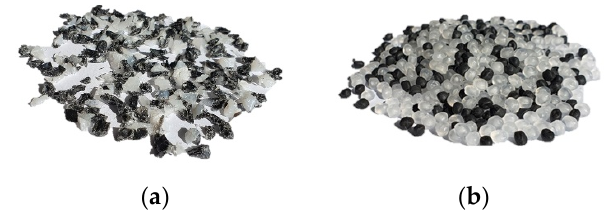
Figure 1. ( a ) Regrind material; ( b ) virgin material granules. When using grooved feed zone extruders, regrind material comprises a lower bulk density, resulting in a reduced specific throughput (throughput per screw revolution). This in turn decreases the extruder’s efficiency [1]. The extruder’s lower specific throughput leads to a higher melt temperature, which devalues the melt quality (Figure 2b, red area). The melt temperatures can be lowered by a reduced screw speed. (Figure 2b, gray area). This shows that regrind processing essentially reduces the extruder’s process